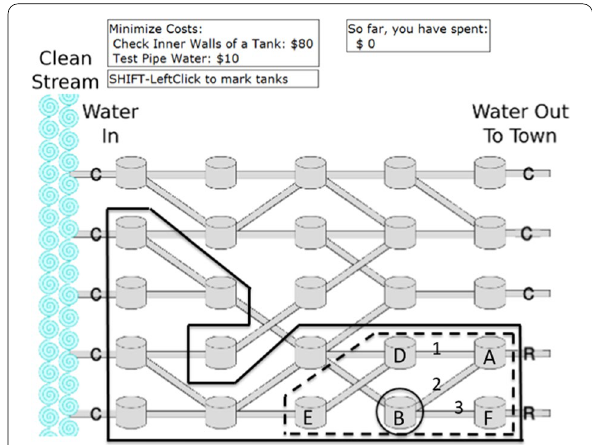
Fig. 1 Initial display (before any tests made) for a fault diagnosis problem, showing a network of water storage tanks with water flowing from left to right and observations of clean (C) and rusty (R) water flowing in pipes. The overlays (which were not shown to participants) show the reduced fault set after using general backtracking (solid straight lines), elimination (dashed lines), and IBE (circle) based on the network outputs at the beginning of the problem. The pipe numbers and tank letters were not shown to participants. The rusty tank is